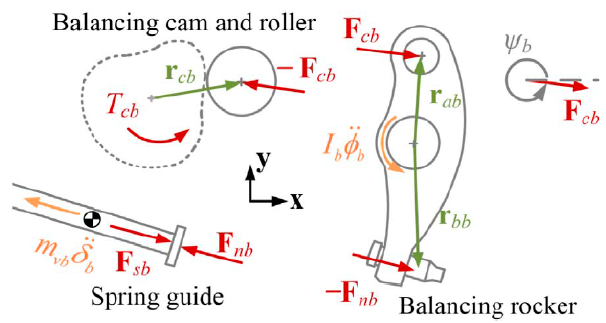
Figure 17. FBD of the proposed balancing mechanism [34]. The mechanism was able to cancel the resistive torque generated by the valve mechanism. Figure is reprinted with permission from publisher.